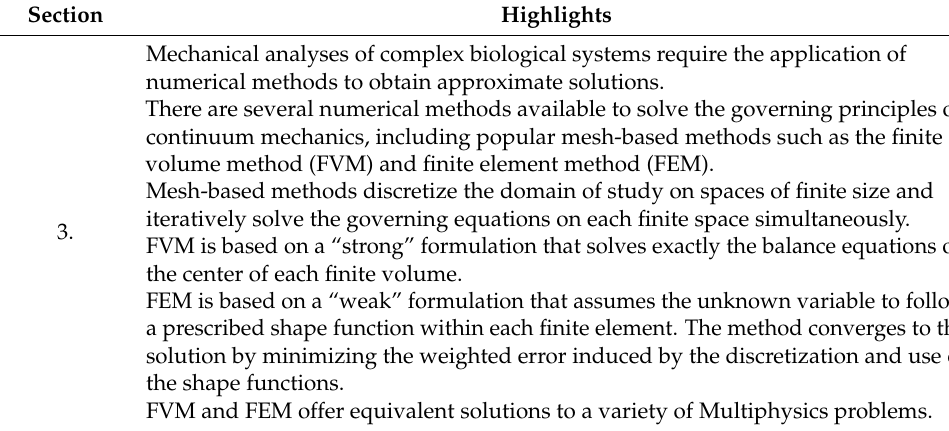
Table 2. Summary of numerical